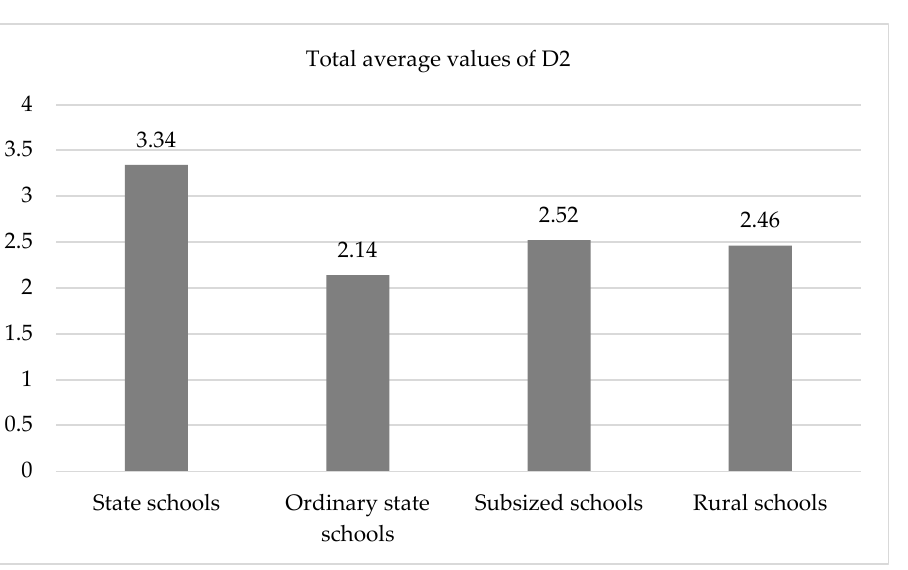
Figure 2. Diagram of means. Overall mean values of D4 as a function of the type of school ( p < 0.01).